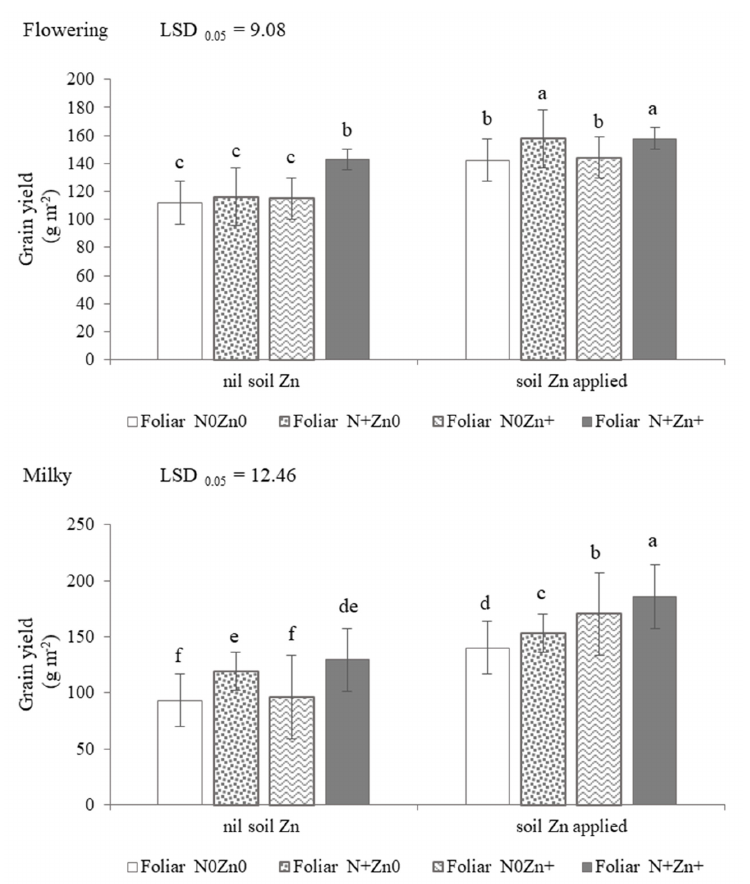
Figure 1. Grain yield in the SPT1 rice variety grown at different foliar N and Zn application rates under two soil Zn conditions at the flowering and milky stages. Each value is the mean of four independent replications. Different letters above the bars indicate a significant difference by LSD (0.05). The error bars indicate the standard deviation of each treatment mean (SD) ( n = 4).